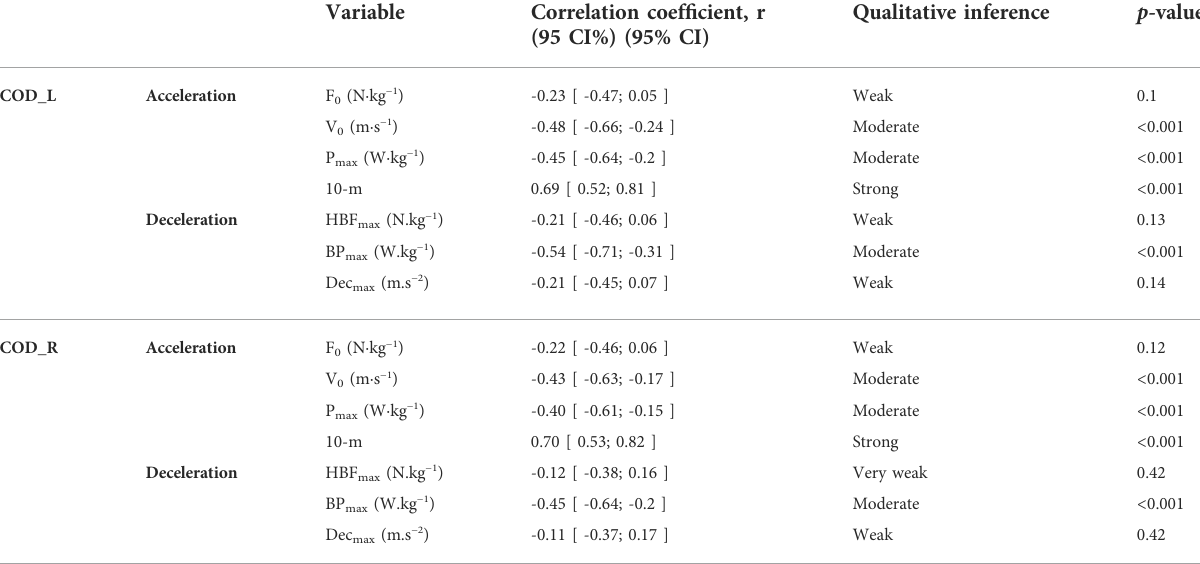
TABLE 3 Associations between acceleration and deceleration mechanical parameters and COD performance on the left side (COD_L) and right side (COD_R) for male players. F 0 : maximal theoretical force; V 0 : maximal theoretical velocity; P max : maximal power; 10 m: 10 m split time; HBF max : maximum braking force; HBP max : maximum braking power; Dec max : maximum